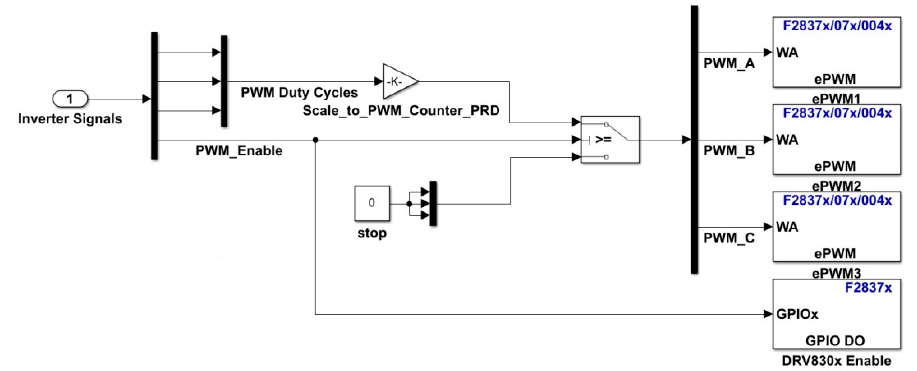
Figure 32. MATLAB/Simulink block diagram subsystem for PWM signals generation—HIL stage.